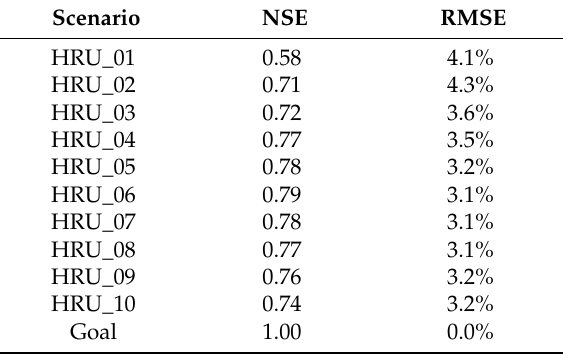
Table 2. Performance of WEAP model in the 10 scenarios using the new methodology. NSE stands for Nash–Sutcliffe efficiency coefficient and RMSE for root mean square error.